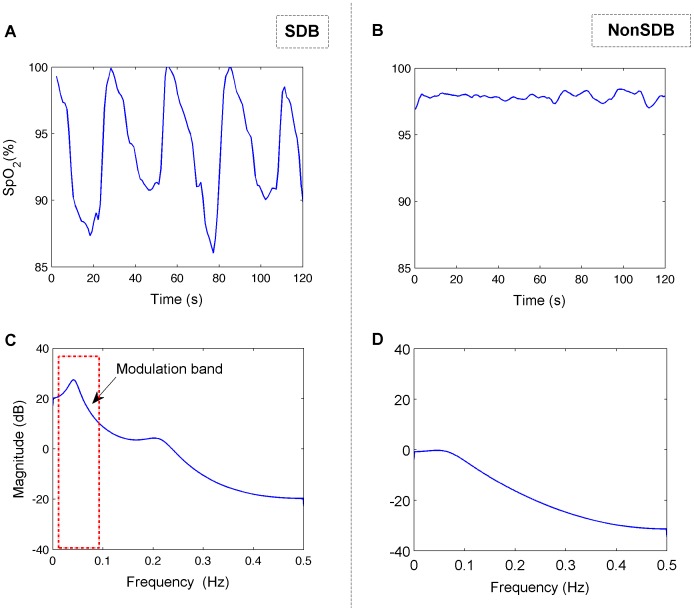
Power spectral density applied to a 2-minute SpO2 signal of (A) a child with, and (B) without SDB.The SDB child shows a clear modulation frequency peak, whereas the NonSDB child illustrates no clear modulation peak.